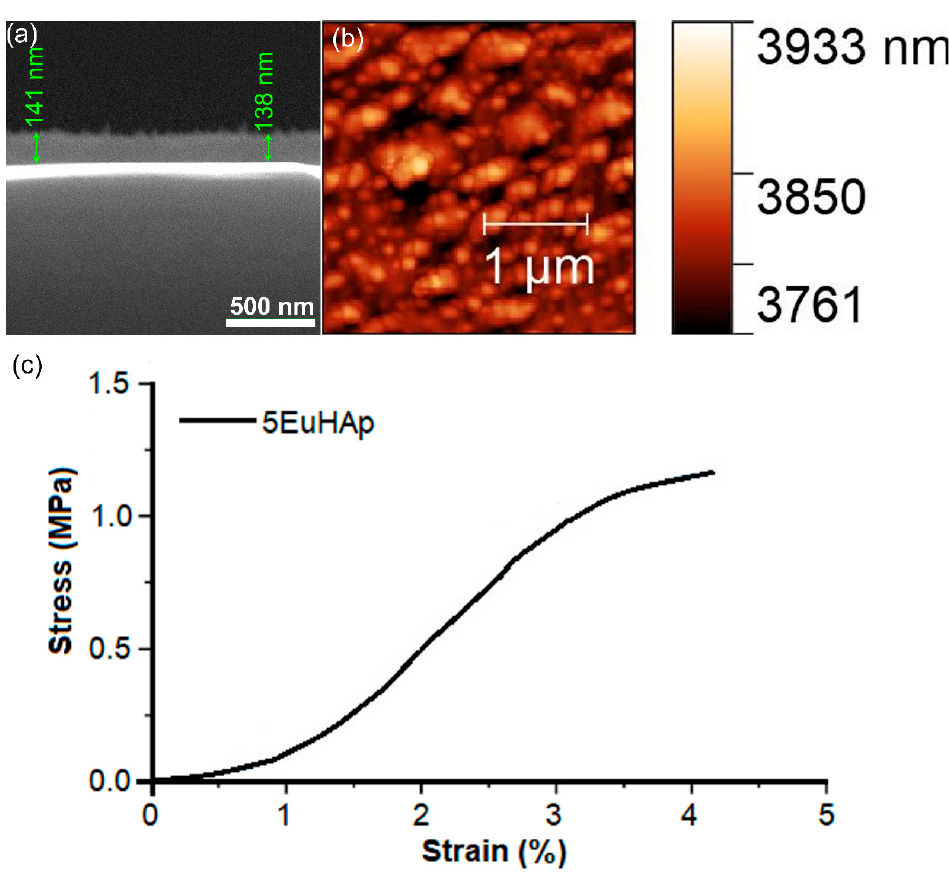
Figure 4. 5EuHAp thin film thickness ( a ), typical 2D AFM images ( b ), and stress–strain curves ( c ).